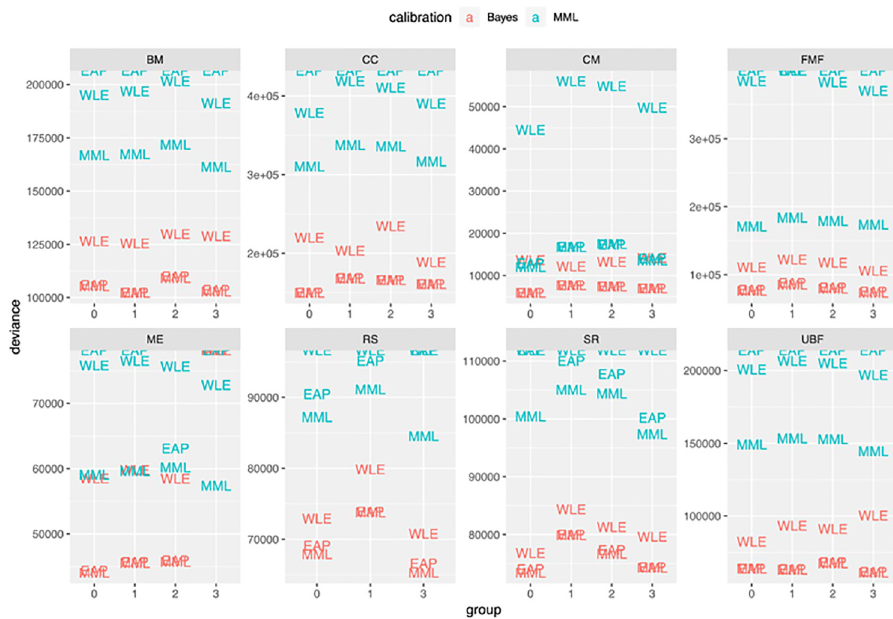
Fig 2. Four fold cross-validation comparison of calibration of and scoring choices for 8 domains of the WD-FAB (lower is better), performed on claimant sample. The deviance measure is computed for each left out fold using Eq 7. This measure is scaled in-line with the AIC so lower values are